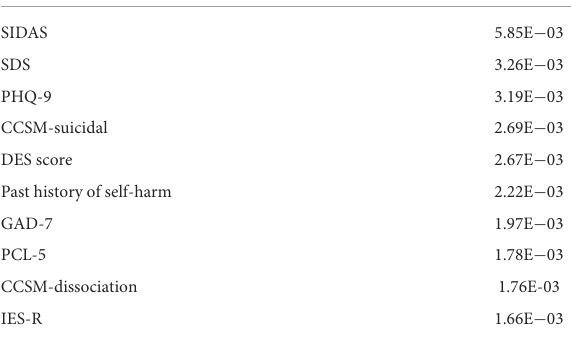
specificity of 80.4%, positive predictive value (PPV) of 63.4%, and negative predictive value of